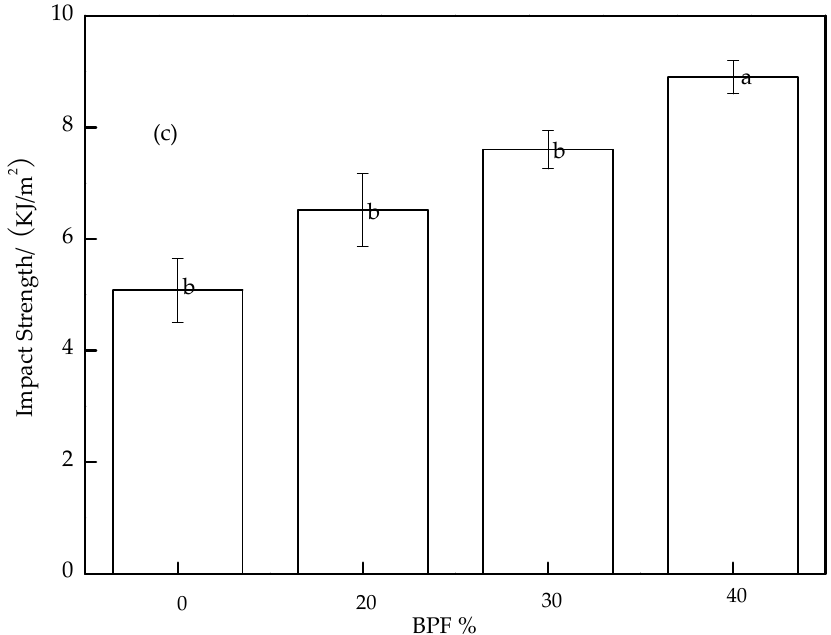
Figure 3. Effects of BPF on mechanical properties of BPCs: ( a ) effects of BPF on flexural property of BPCs; ( b ) effects of BPF on tensile property of BPCs; ( c ) effects of BPF on impact property of BPCs. Letters a, b, c denote significance test.